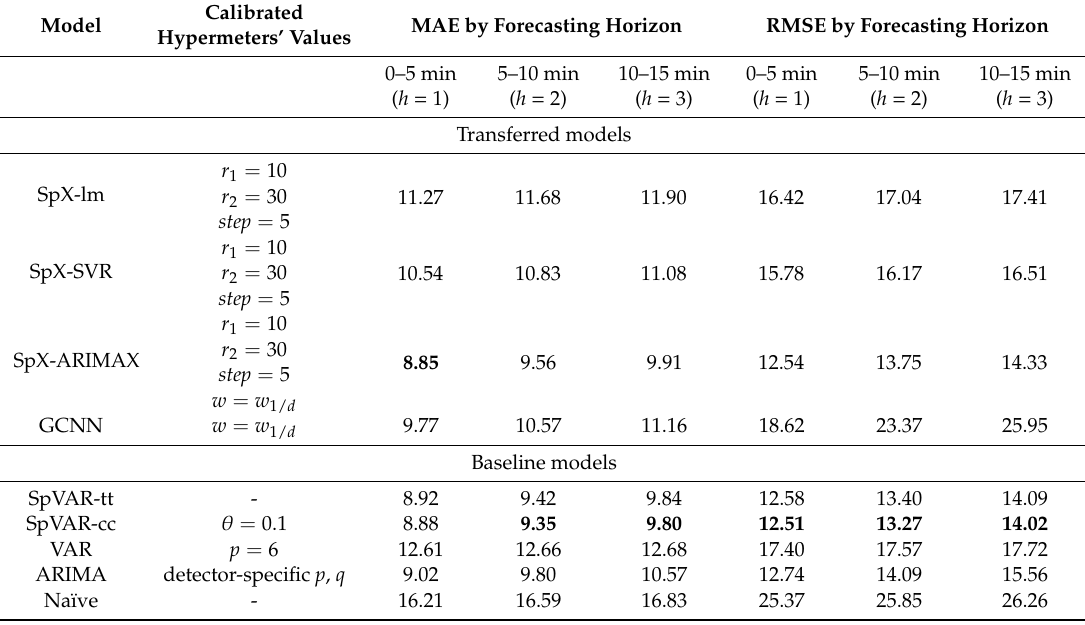
Table 3. Forecasting accuracy of the research models.